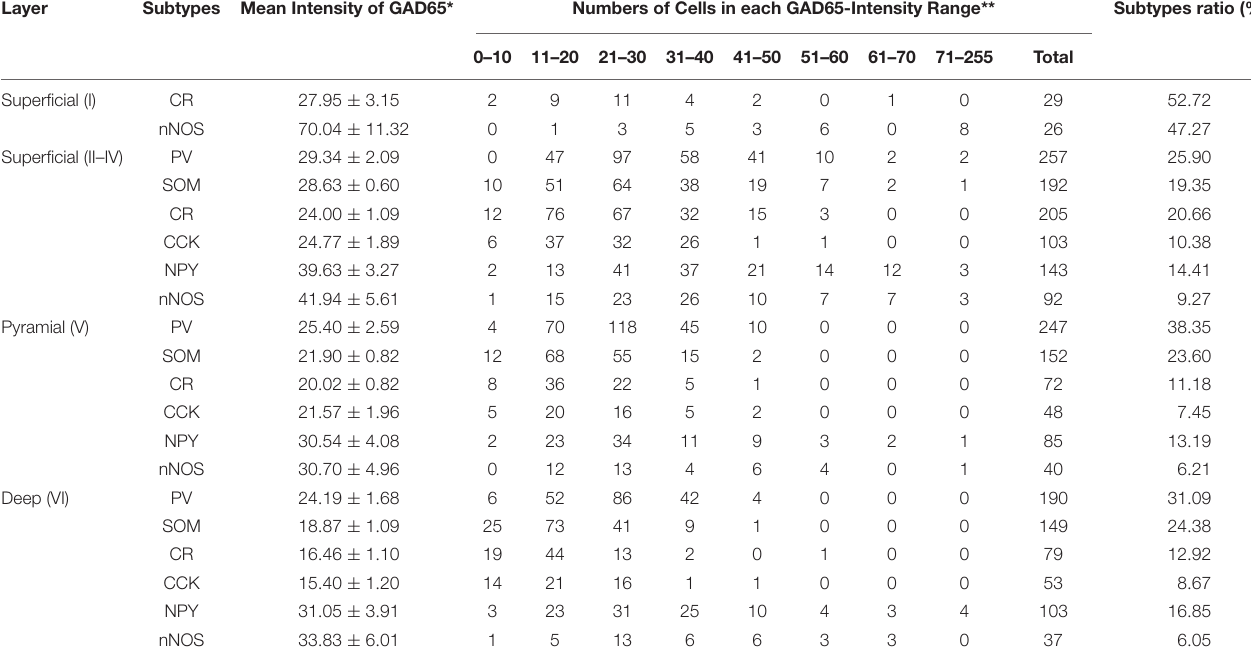
TABLE 1 | GAD65 Expression in Cerebral Cortical Layers Based on GAD65 Staining Intensity. Layer Subtypes Mean Intensity of GAD65* Numbers of Cells in each GAD65-Intensity